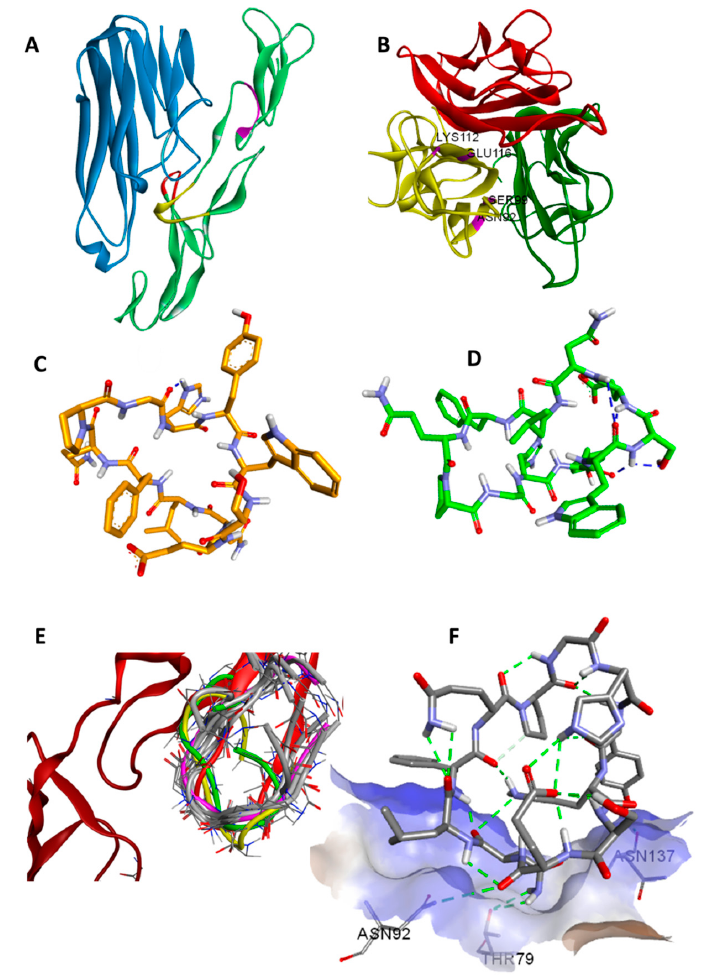
Figure 1. Modelling of the inhibition of TNF α -TNFR1 interaction. ( A ) This figure shows the di ff erent binding sites of TNFR1 based on the available crystal structure of TNF β / TNFR-1 complex [PDB: 1TNR]. The TNF β structure (blue) bound to TNFR-1 (green) with highlighted 3 TNFR1 binding sites, WP5 (magenta), WP8 (yellow) and WP9 (red). ( B ) 3D view of TNF α homo-trimer (PDB: 1TNF) showing residues N92, S99, K112 and E116 (magenta) at the interface that are important for the formation of the TNF α bioactive complex. The lowest energy NMR structures of 1 are clustered into two main groups, a major group of seven structures, in which ( C ) is the lowest energy conformation and a minor group of three structures in which ( D ) is the lowest conformation in the cluster. ( E ) illustrates structural similarity between different structures of 1 and WP9 domain. Aligned and superimposed docking poses and NMR structures of 1 against the WP9 loop of TNFR-1 are shown in red to illustrate their structural similarity. Docking pose 6 is shown in purple, and major and minor NMR structures are coloured in yellow and green, respectively. ( F ) WP9 loop peptidomimetic 1 docked to TNF α (PDB: 1TNF). The interaction involves four hydrogen bonds with N137, N92 and T79 residues of TNF α ; details can be found in Table S1.